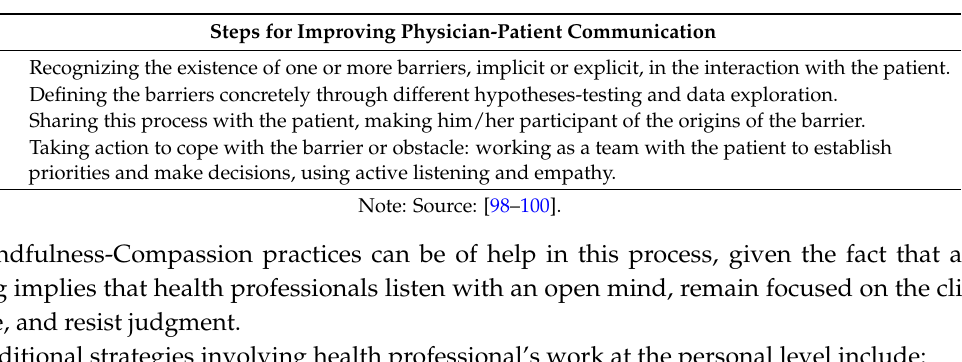
Table 3. Steps to manage difficulties in physician-patient communication.